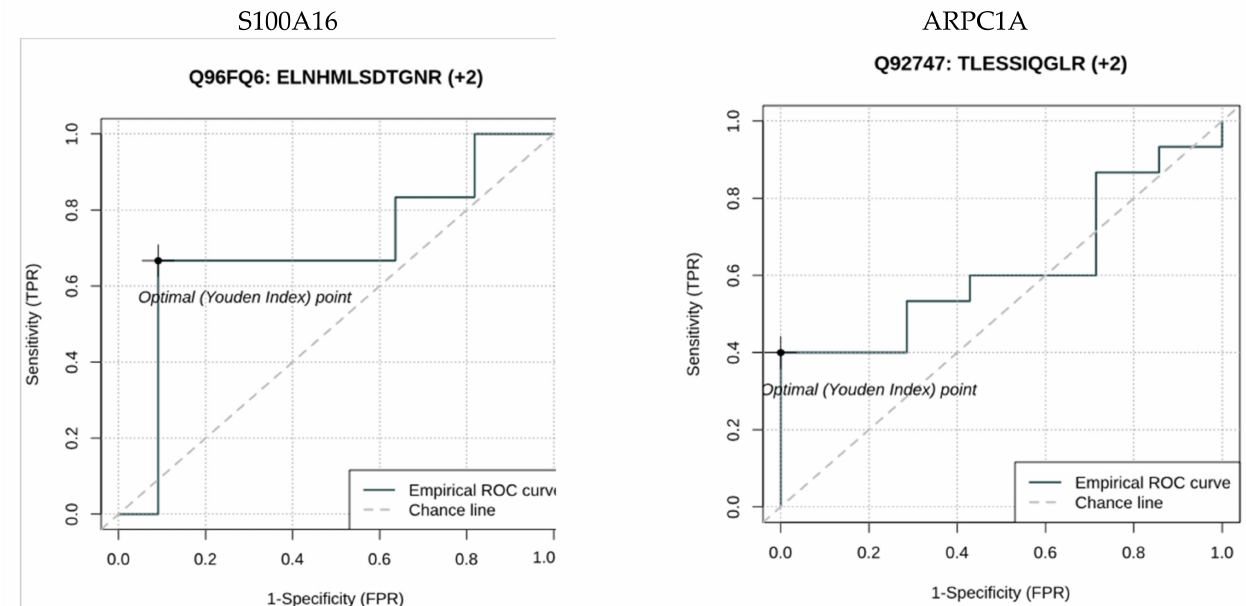
Figure 1. Area under the curve (AUC) receiver operating characteristic curve (ROC) analysis for S100A16 and ARPC1A proteins in HC versus PD